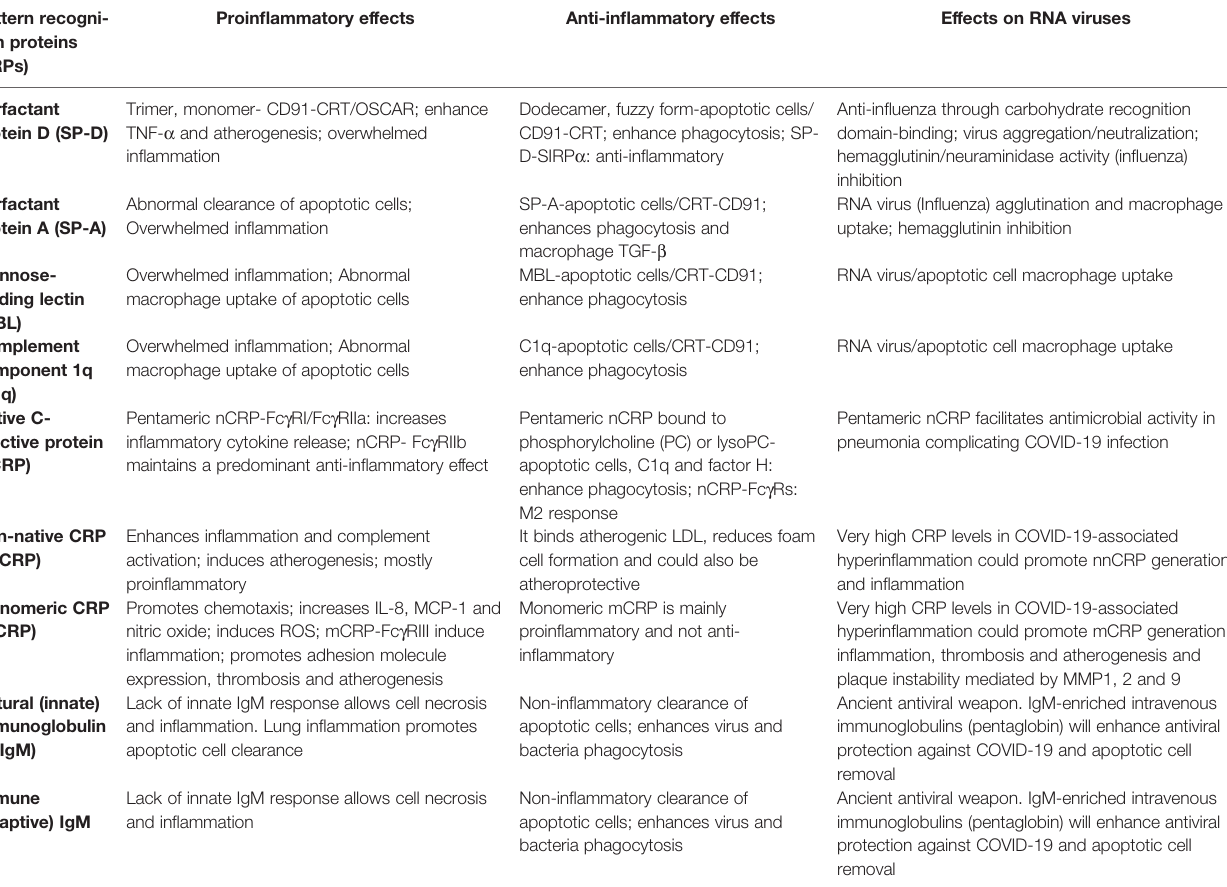
TABLE 1 | Summary of pattern recognition proteins (PRPs) proin fl ammatory, anti-in fl ammatory and antiviral effects. Pattern recogni- tion